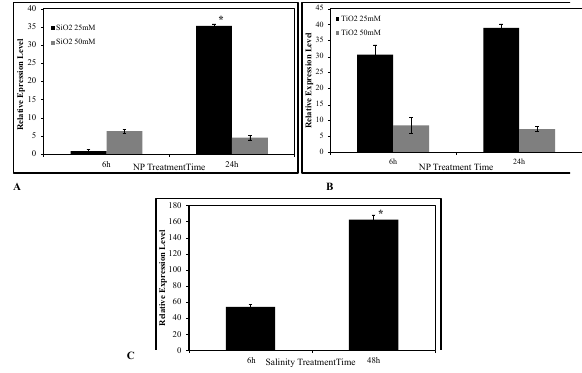
Fig. 5. The effect of elicitors on expression of TpGAS gene in fever- few. A: SiO 2 NP treatment; B: TiO 2 NP treatment; C: Salinity stress.